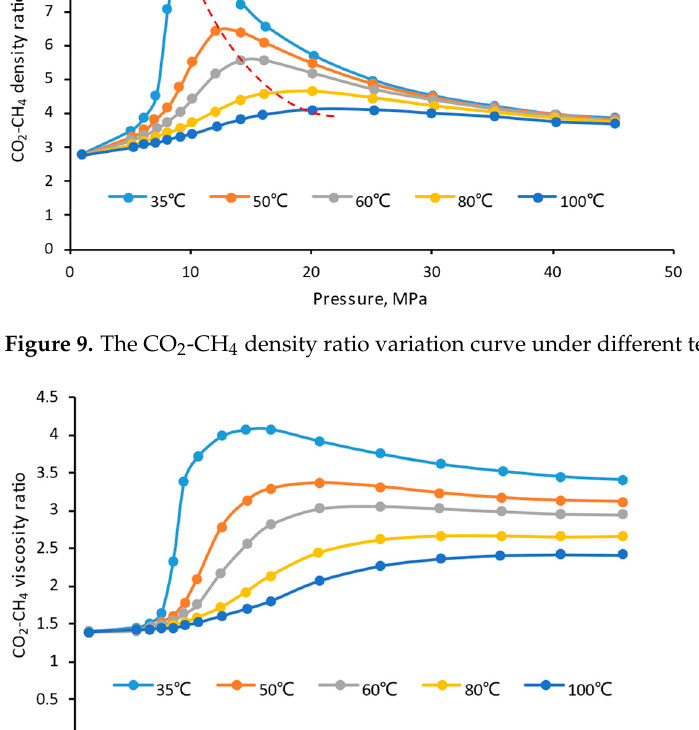
Figure 10. The CO 2 -CH 4 viscosity ratio variation curves under different temperatures and pressures.